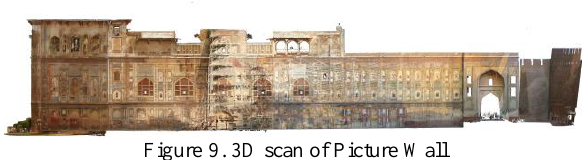
Figure 9. 3D scan of Picture Wall